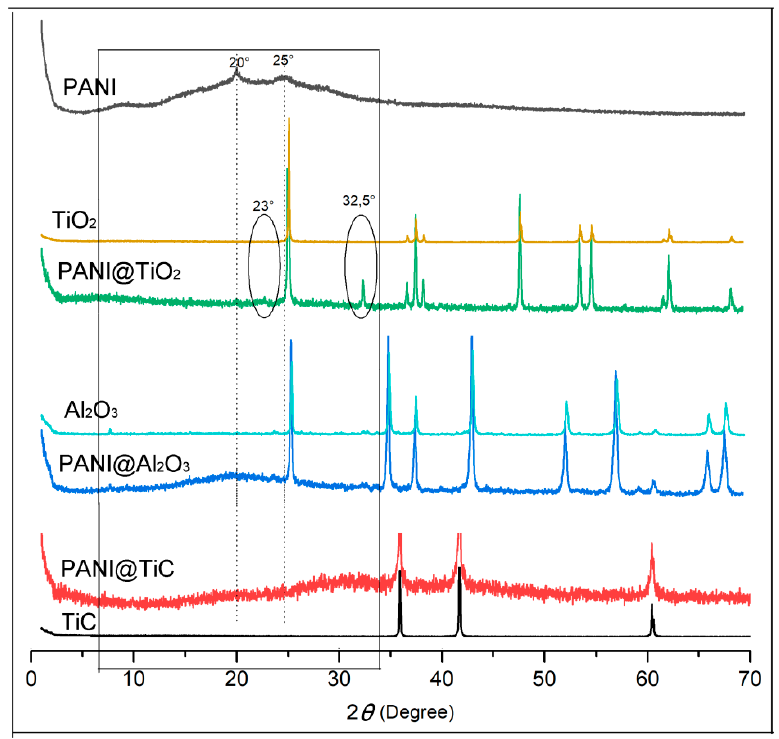
Figure 4. X-ray diffraction (XRD) patterns of the PANI, PANI@TiO 2 , PANI@TiC, PANI@Al 2 O 3 , TiO 2 , TiC, and Al 2 O 3 materials.